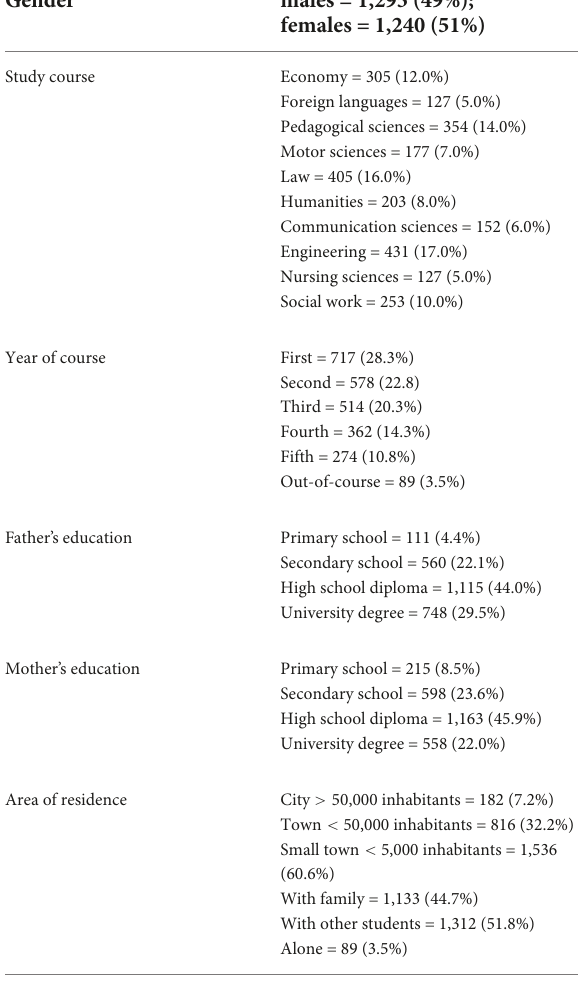
TABLE 1 Characteristics of the